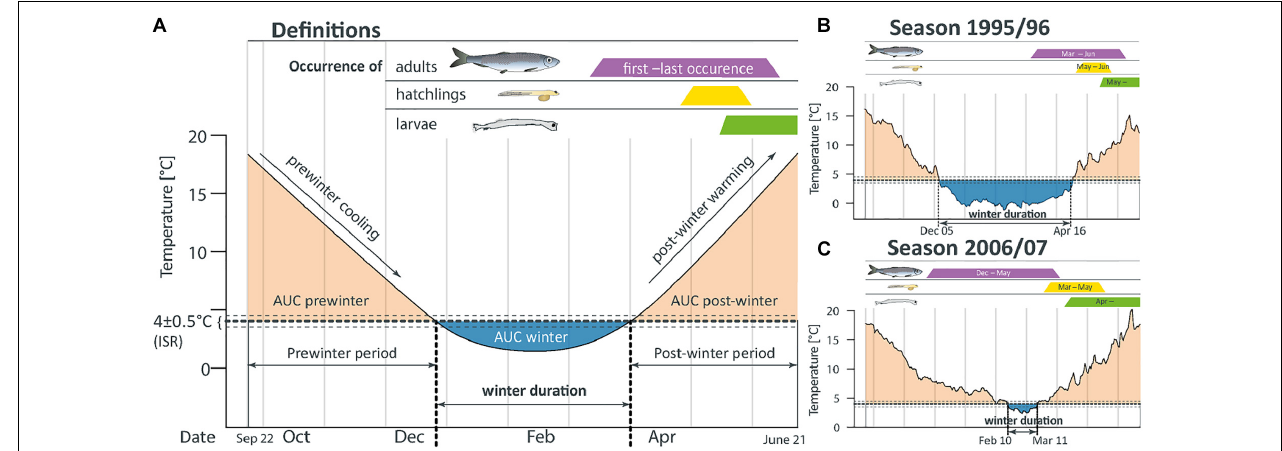
FIGURE 2 | (A) Schematic of the best candidate winter descriptors identified by the model. Dashed horizon indicates the initial spawning range (ISR). AUC represents the area under the curve. Exact definitions of the descriptors are provided in Supplementary Table S1 . The particular seasonal periods are assigned to herring life stages in the system. Two opposing extreme years with differing regional SST curves are presented in (B,C) to illustrate the application of the concept. The full set of SST curves for the 26 years studied is provided in Supplementary Figure S2